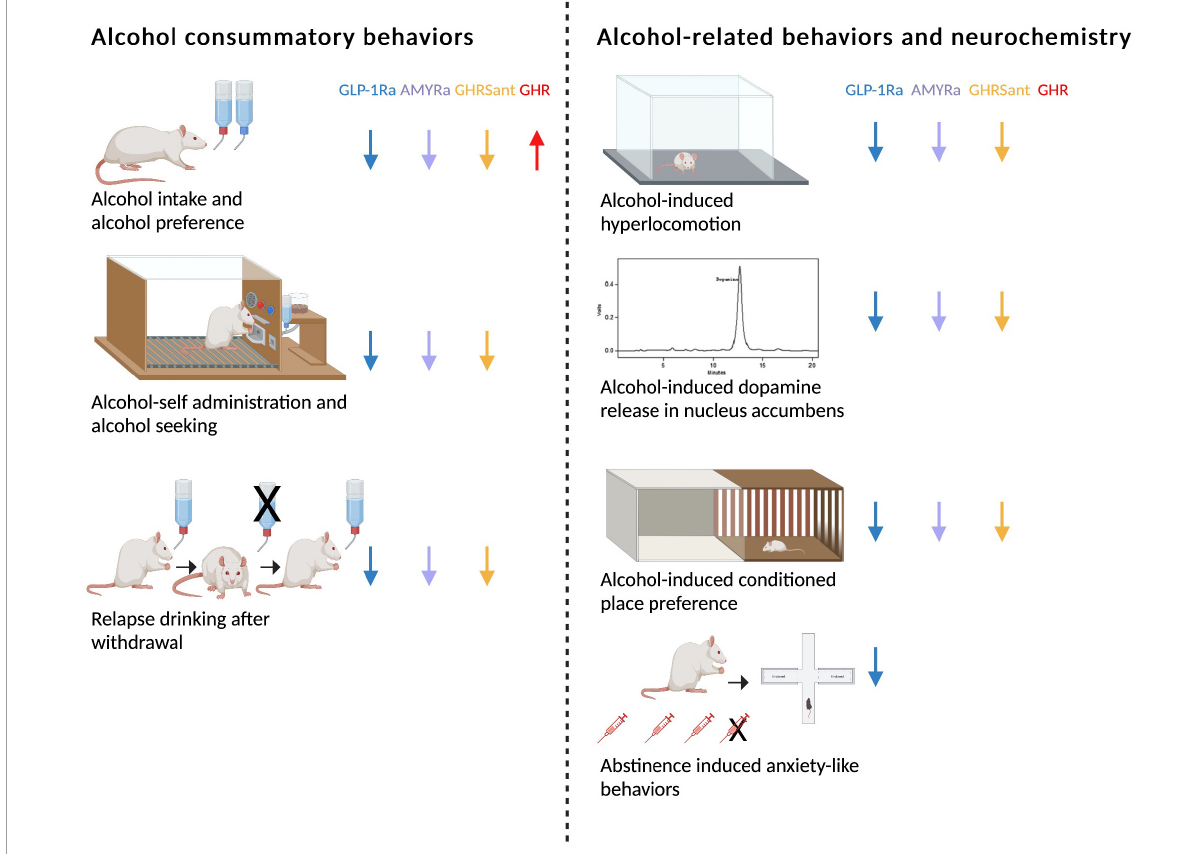
FIGURE1 Schematic summary of how glucagon-like peptide-1 receptor agonists (GLP-1Rant), amylin receptor agonists (AMYRa), ghrelin receptor antagonists (GHSRant), and ghrelin (GHR) influence alcohol consummatory behaviors and alcohol-related behaviors and neurochemistry in rodents ( ↓ ; decrease, ↑ ; increase). Created by